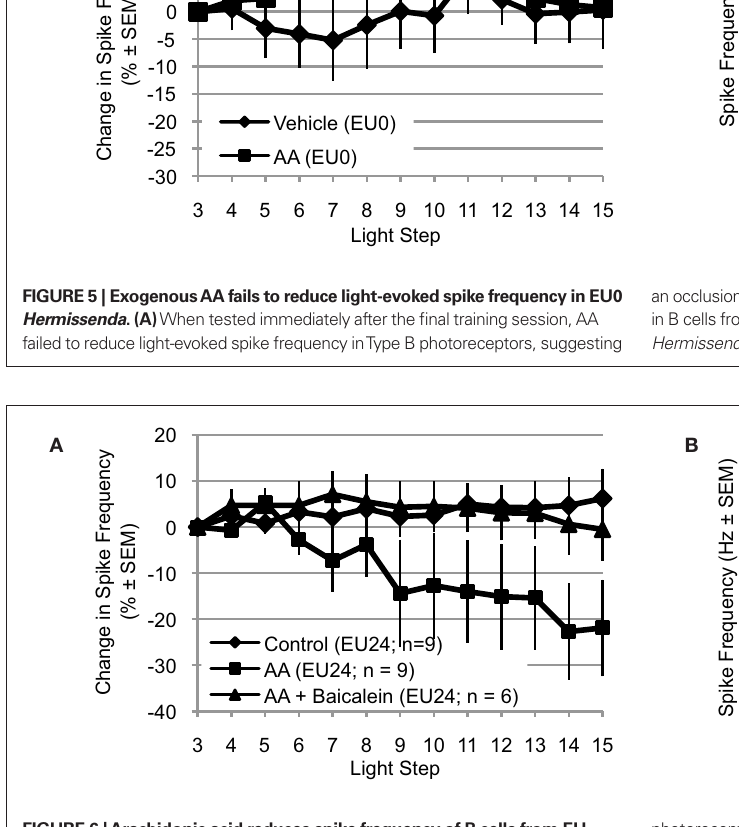
FigurE 6 | Arachidonic acid reduces spike frequency of B cells from Eu trained animals, when tested 24 h post-conditioning (Eu24 condition). The EU training related reduction in Type B photoreceptor light-evoked spike frequency is mediated by 12-lipoxygenase signaling. (A) AA reduced light- evoked spike frequency in Type B photoreceptors from EU24 Hermissenda . This reduction was blocked by incubation in baicalein. (B) Left half. For Type B